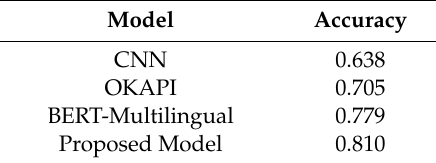
Table 3. Performance comparison.